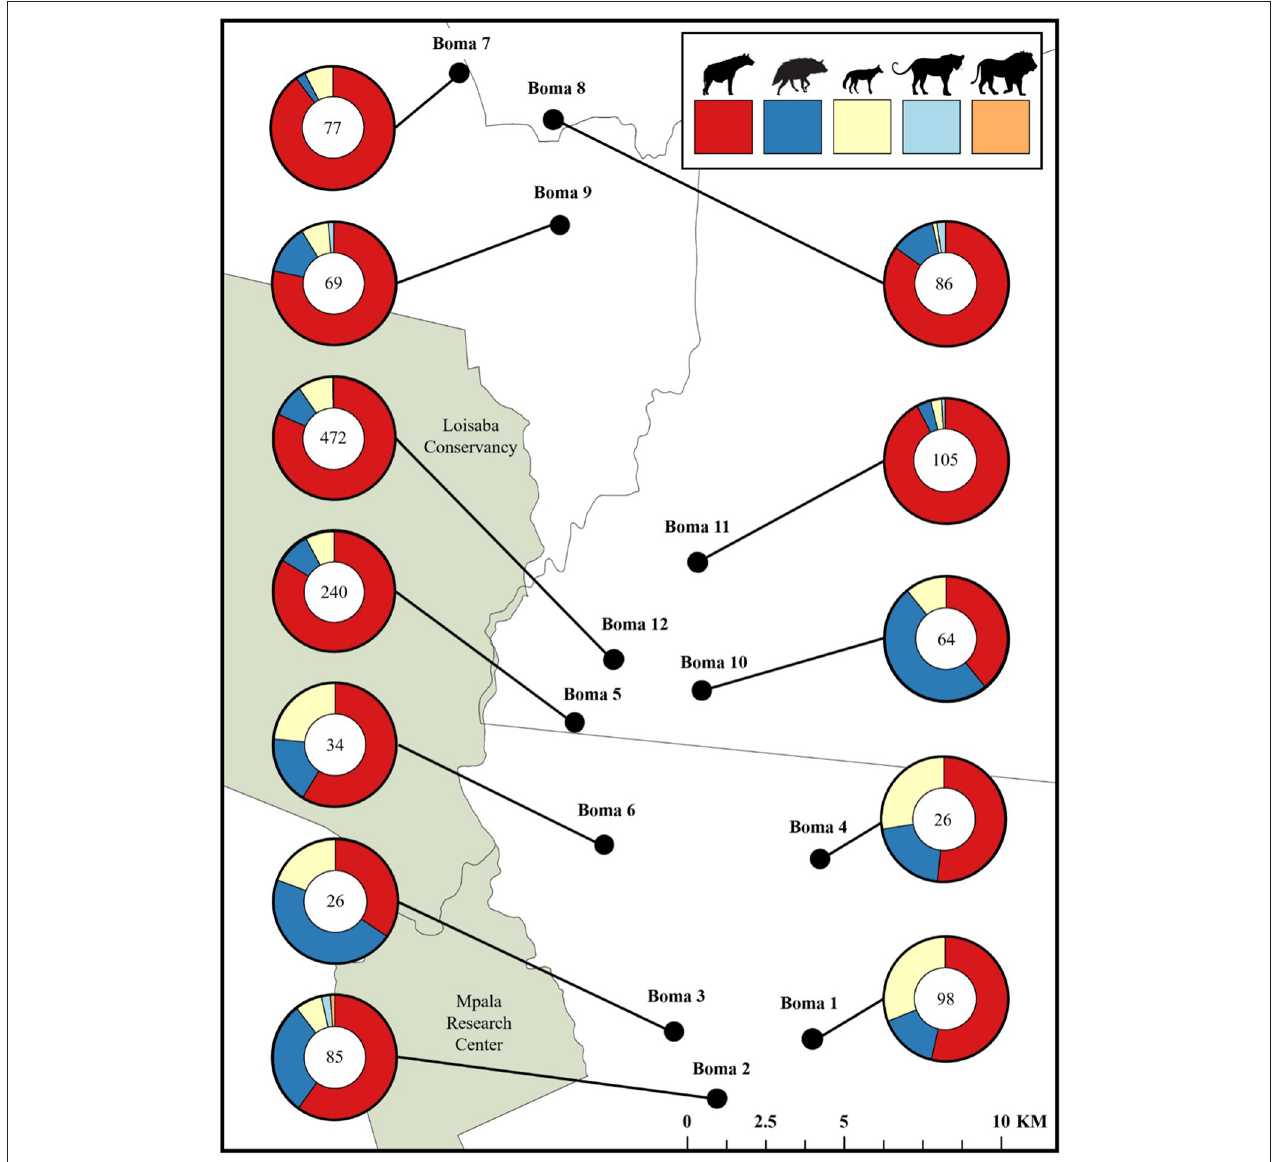
FIGURE 6 | The proportion of carnivore-livestock encounters attributed to each of the five recorded carnivore species at 12 bomas in Central Kenya from September, 2018 to May, 2019. Each chart also indicates the total number of carnivore-livestock encounters at the